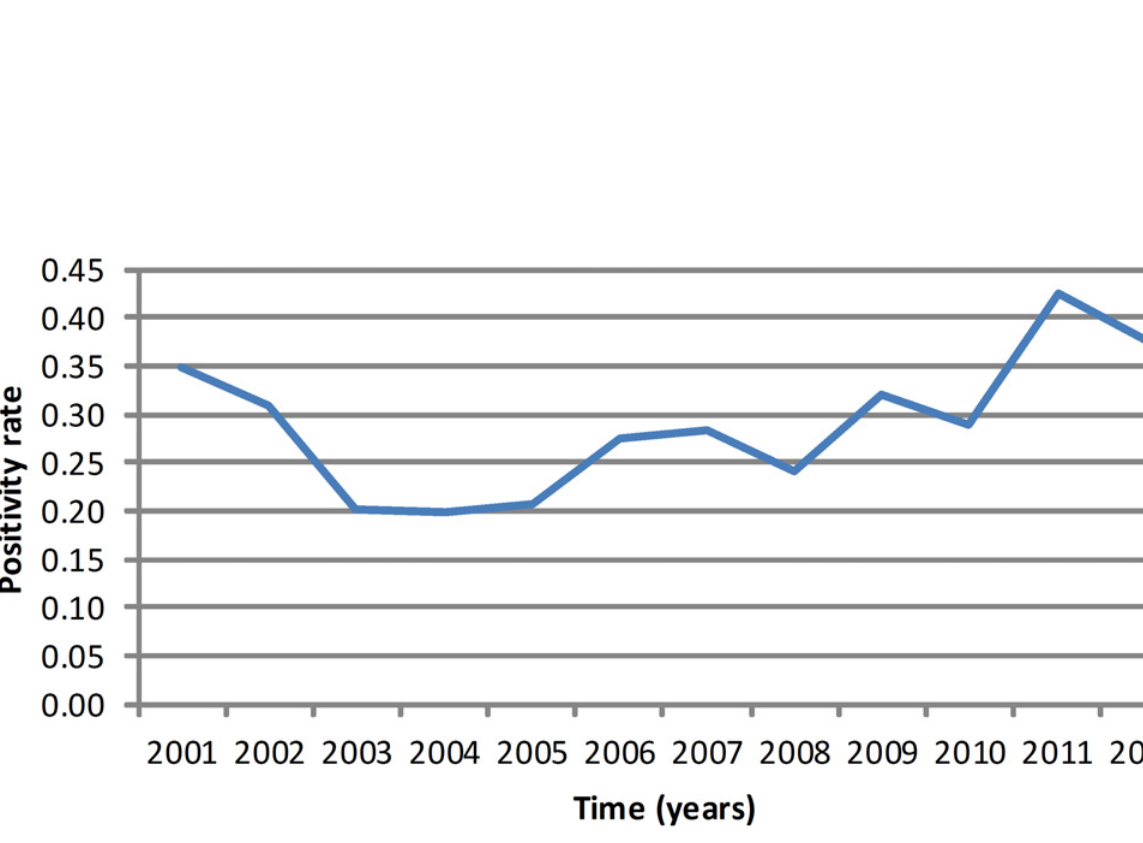
Fig 6. Spatial representation of the positivity rate of animal rabies in Minas Gerais, Brazil, from 2001 to 2012.